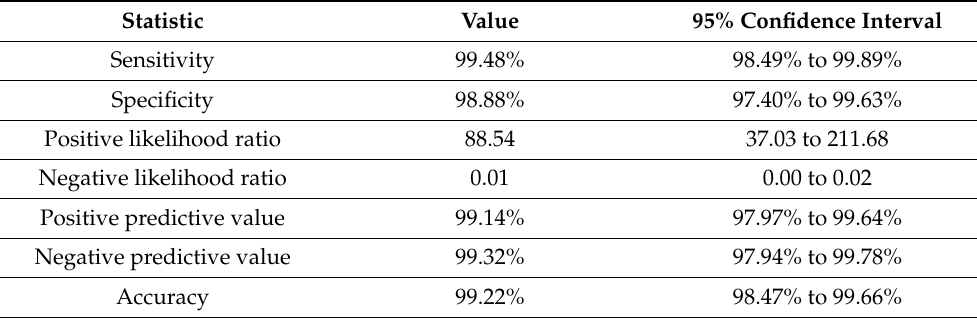
Table 6. Test statistics and confidence intervals regarding the support vector machine classification using a quadratic